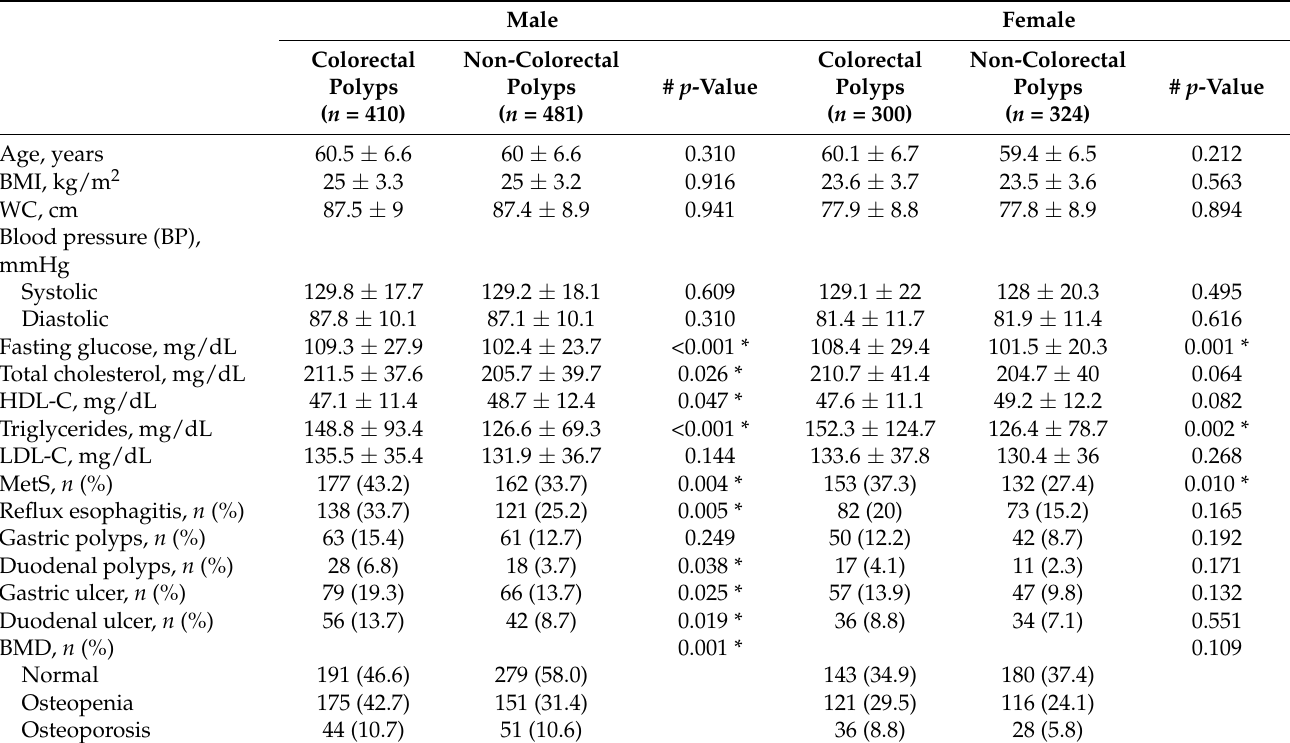
Table 2. Differences between colorectal polyps group and non-colorectal polyps group stratified by